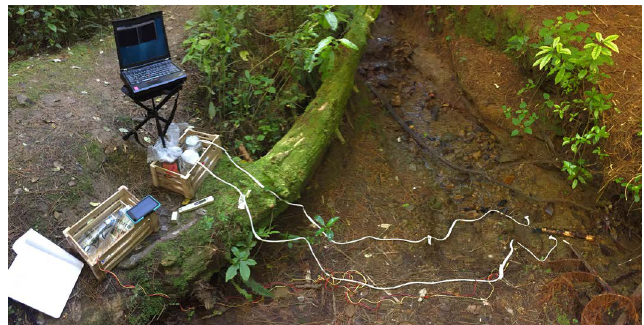
Figure 1: Testing and debugging the Papawai Transmissions network in the